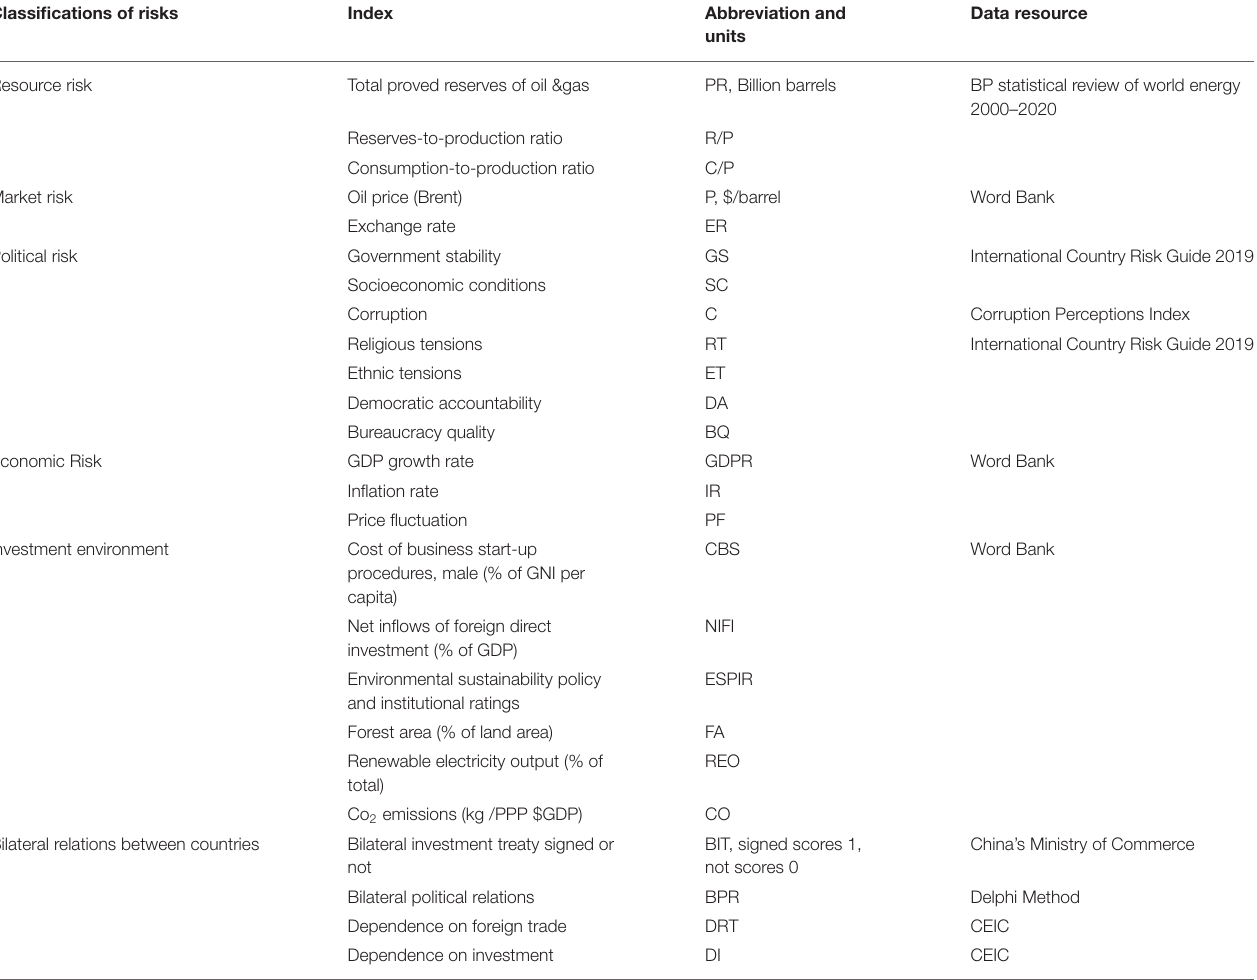
TABLE 3 | Oil and Gas Overseas Investment Environment Assessment Indicators